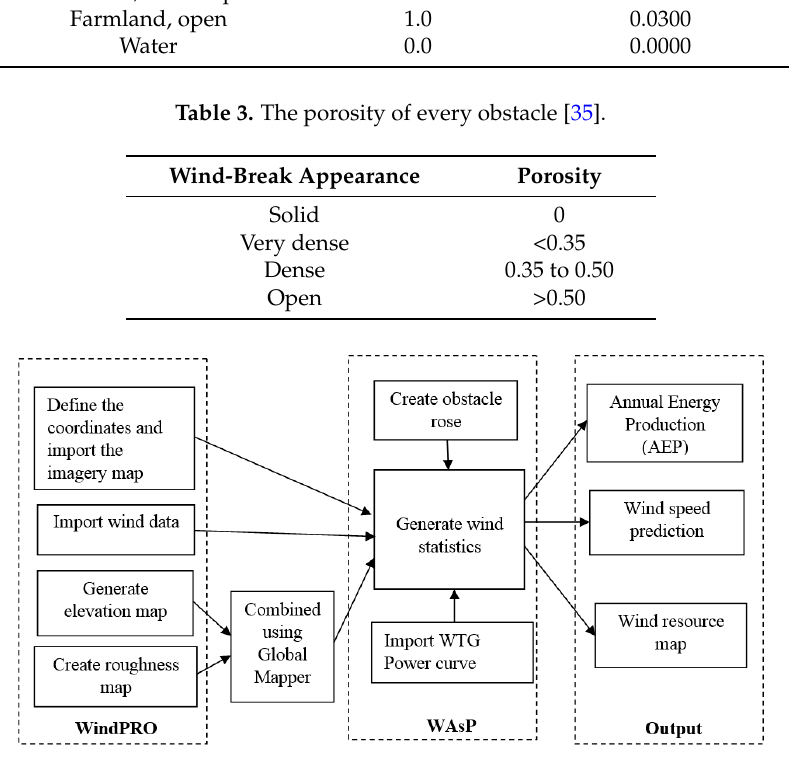
Table 2. The values of roughness class and length [35].